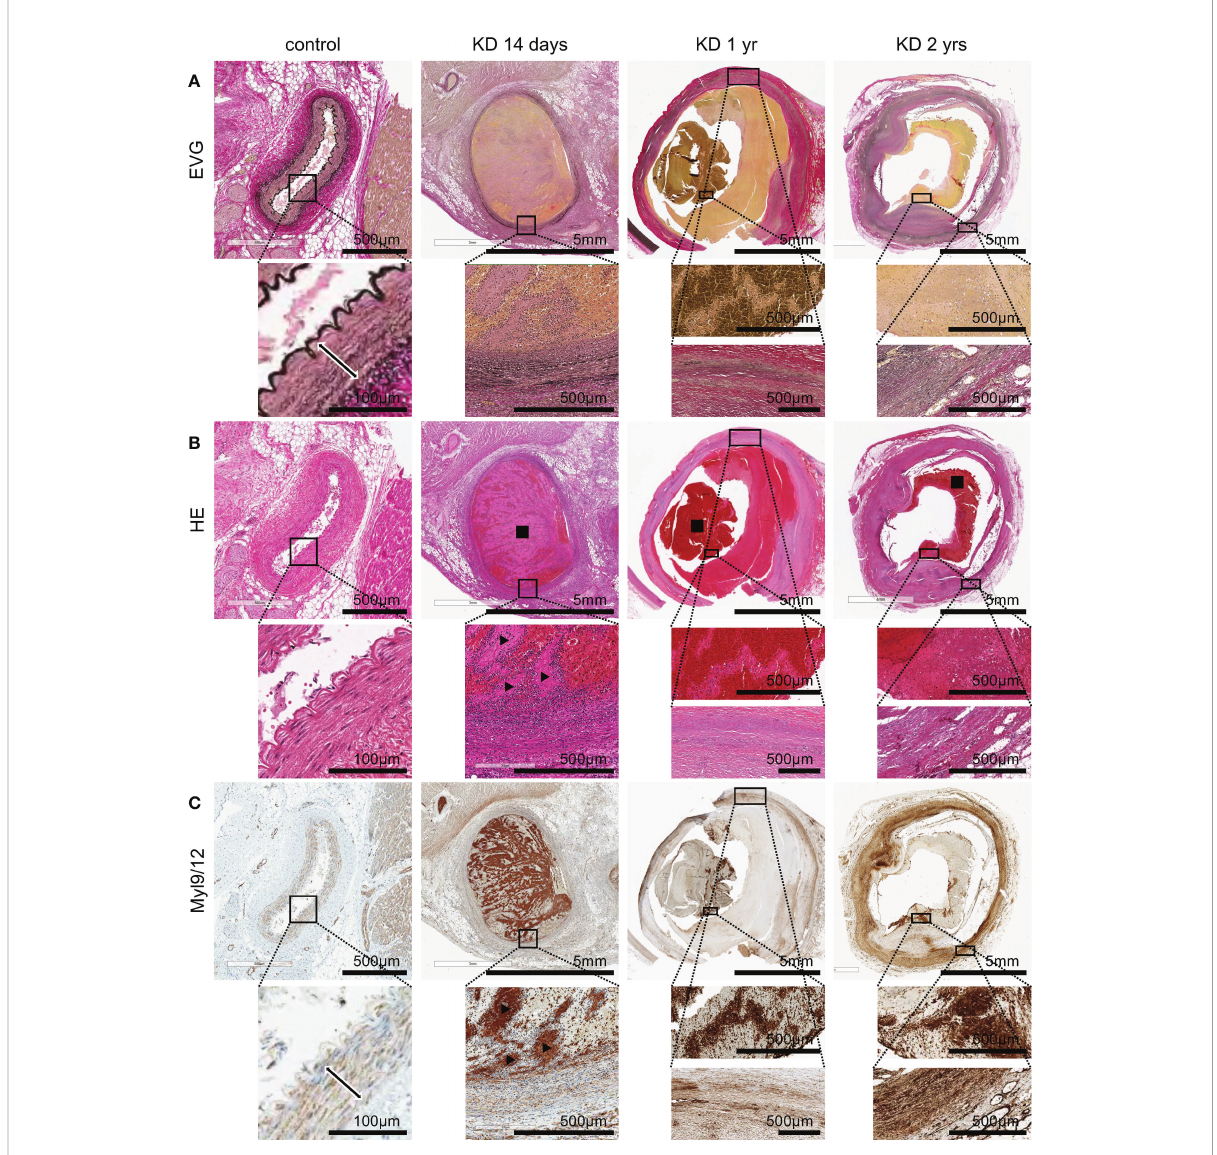
FIGURE 5 Myl9/12 expression in heart tissues collected from KD patients. (A) Elastica-van Gieson (EVG) staining of the coronary artery in a control patient (left), KD patients who died on the 14th day of illness (2nd from left), at 1 year after illness (3rd from left), and 2 years after illness (right). Each upper fi gure shows the coronary artery (giant coronary artery aneurysm in KD patients), and the area surrounded by the square indicates a high- power fi eld. The double-headed arrow indicates medial smooth muscle in the control patient. (B) HE staining of the same area shown in (A) Black square indicates thrombus, black arrowhead indicates white thrombus. (C) Myl9/12 staining of the same area shown in (A, B) Double- headed arrow indicates medial smooth muscle. Black arrowhead indicates white